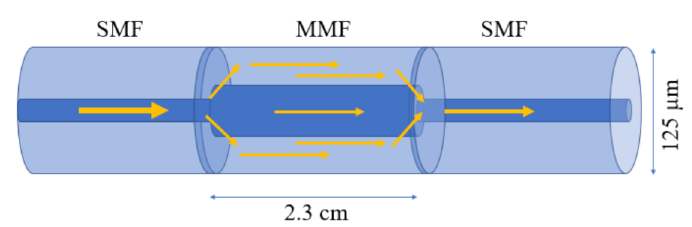
Figure 1. Schematic diagram of a fiber hetro-core